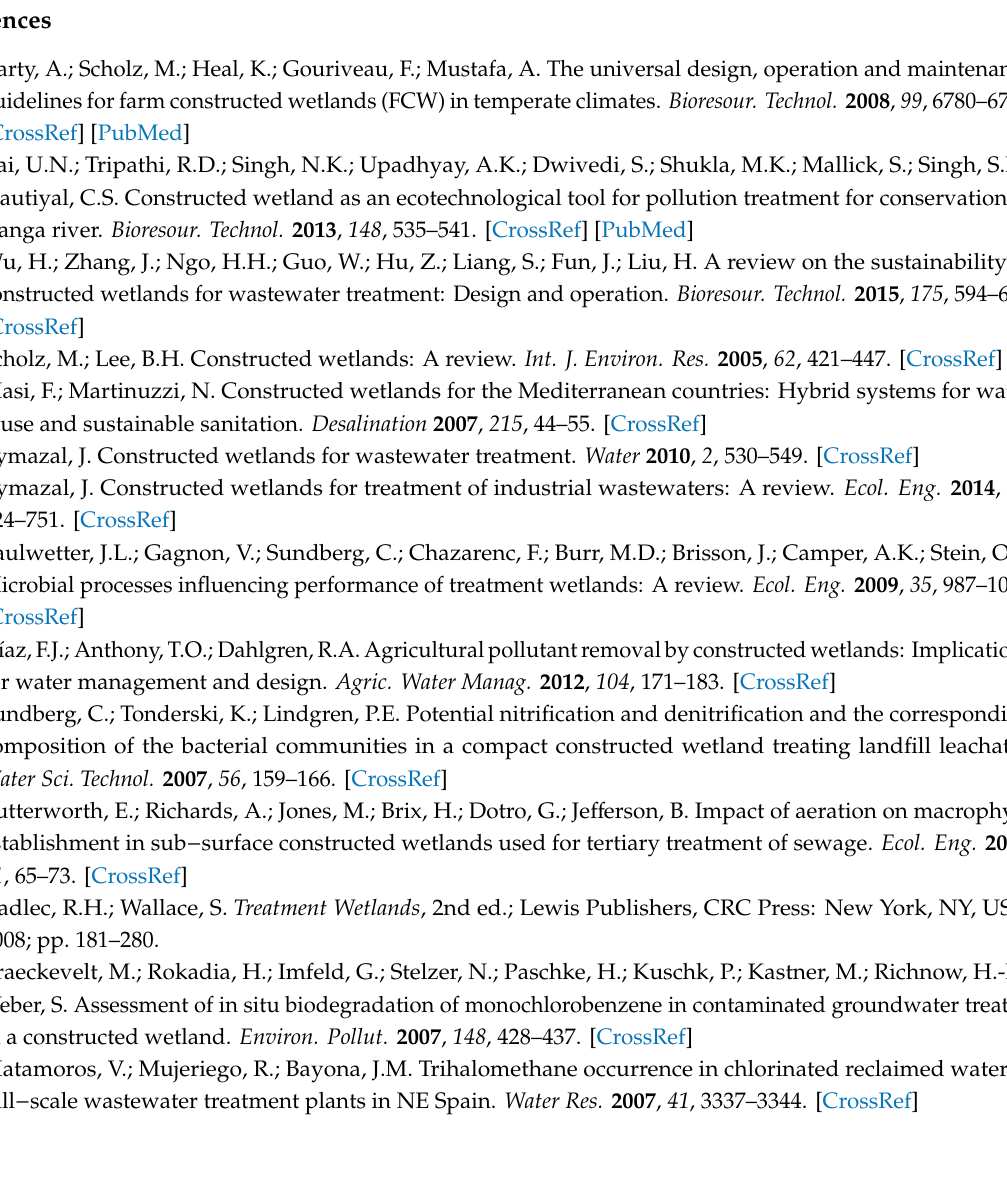
Table S1: Concentrations of individual PAH compounds in sediments of di ff erent functional zones across the constructed wetland. Table S2: Total extracted DNA concentrations and obtained number of nucleotide sequences in sediments of di ff erent functional zones across the constructed